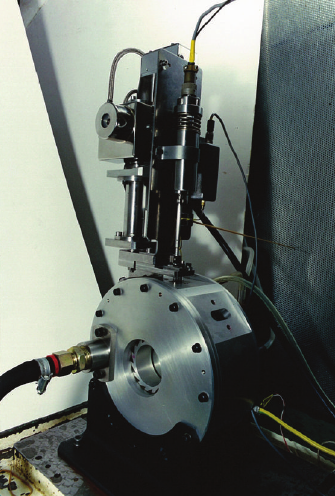
Figure 7: The spinning rig used to evaluate performance of the FM capacitance probe.